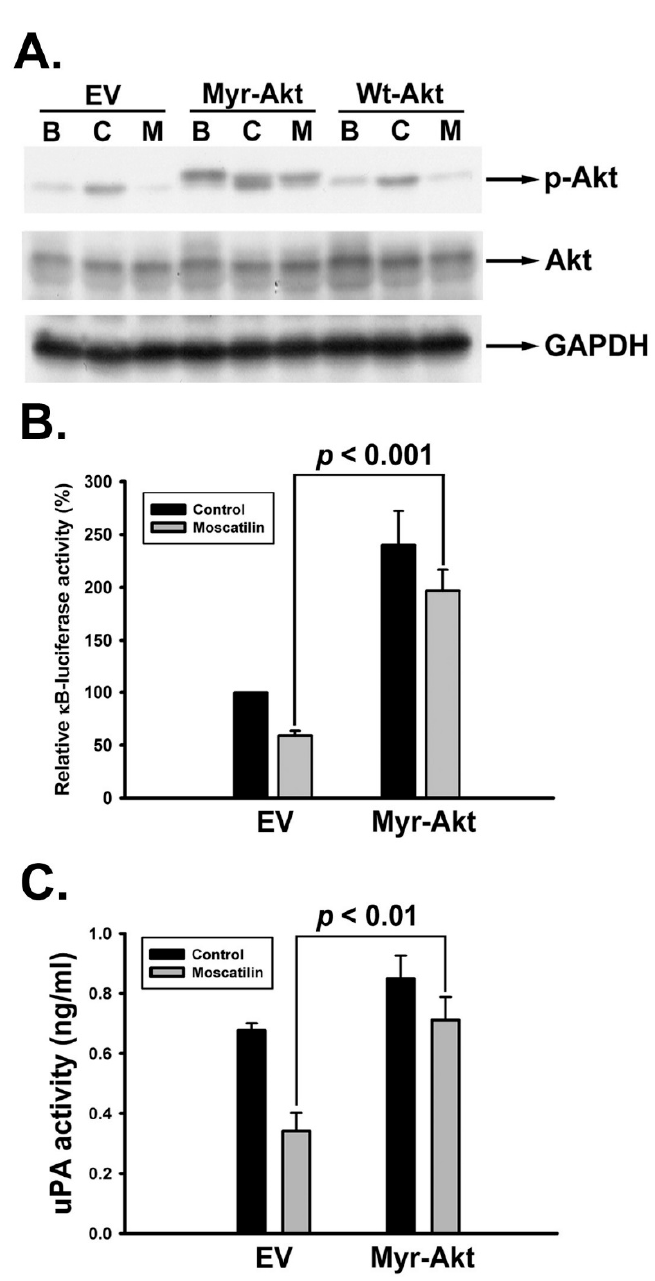
Figure 6. Involvement of Akt/NF- κ B signaling pathway in moscatilin-suppressed uPA activity in human HCC cells. ( A ) SK-Hep-1 cells-transfected with empty vector (EV) or Myr-Akt or Wt-Akt were treated with vehicle (basal, B) or 10% FBS in the absence (control, C) or presence of moscatilin (30 µ M, M) for 10 min. Cells were harvested and lysed for the detection of p-Akt by Western blot analysis. The quantitative densitometry of the relative level of protein was performed with Image-Pro Plus. SK-Hep-1 cells cotransfected with pNF- κ B-Luc and Myr-Akt were treated with moscatilin (30 µ M) for 12 h, and NF- κ B luciferase activity ( B ) and uPA activity ( C ) were determined using reporter gene assay and ELISA assay, respectively. Data are expressed as mean ± S.E.M. of four independent experiments.